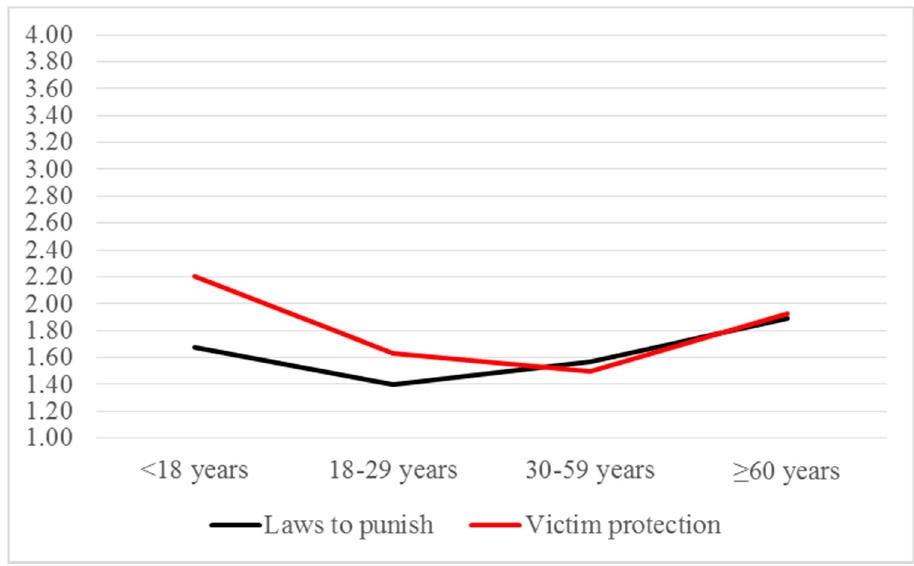
Figure 6. Perception about measures for protecting victims and punishing abusers: means by age groups.